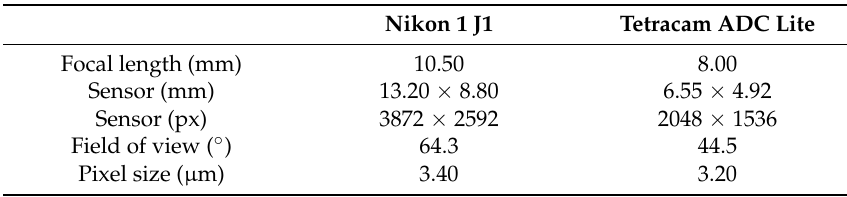
Table 1. Technical specifications of the cameras.